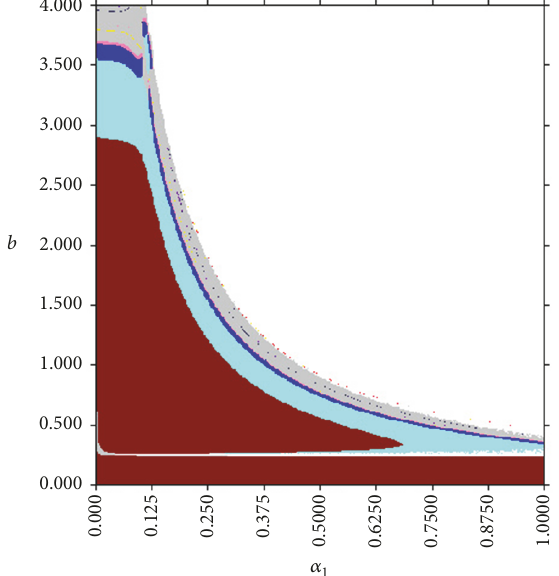
Figure 5: Impact of consumer sensitivity on recycling prices on system stability.